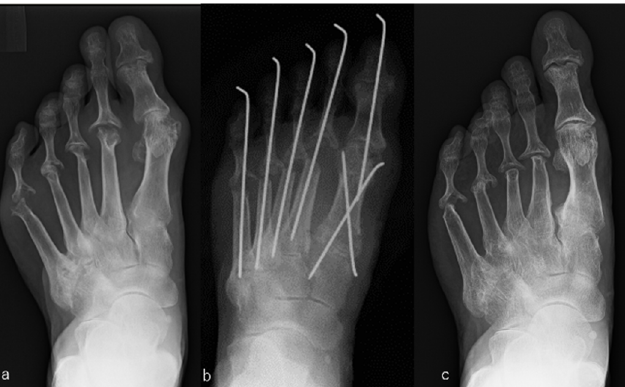
Figure 1. Rheumatoid arthritis (RA) in a 78-year-old woman. Metatarsophalangeal joint-preserving surgery was performed involving the modified Mann method for the big toe and offset osteotomy for lesser toes. RA had been present for 6 years. The patient received bucillamine (200 mg/day) and sulfasalazine (1000 mg/day). Macrographic and radiographic views of her right foot before surgery ( a , b ), immediately after surgery ( c ), and 7 years after surgery, which was the latest follow-up ( d ). The score on the Japanese Society for Surgery of the Foot RA foot and ankle scale improved from 40 points before surgery to 92 points at the 7-year follow-up. The mean hallux valgus angle improved from 45° before surgery to 14° immediately after surgery and was 19° at the 7-year follow-up. The patient was satisfied with the clinical results at the 7-year follow-up, although the correction of the hallux valgus angle had decreased slightly compared with that immediately after surgery.